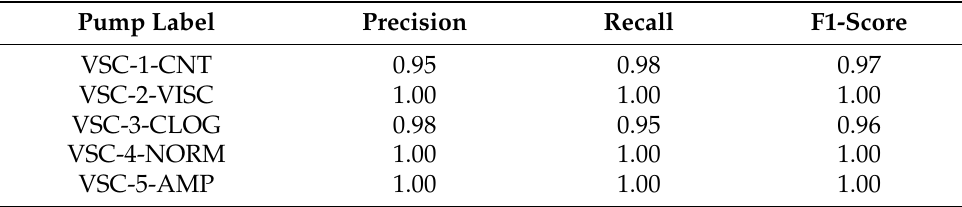
Table 2. Proposed model classification